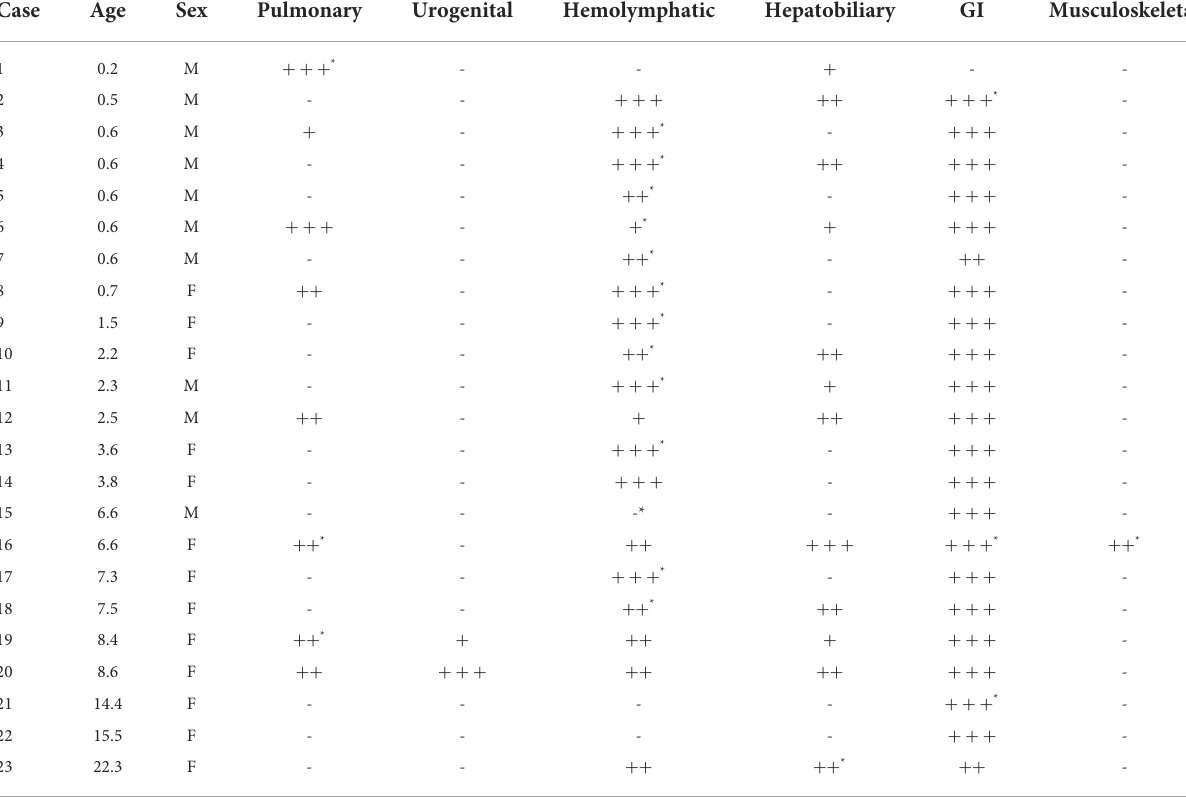
a Casesareorderedbyageinyears.Lesionswerescoredforseverity(-nolesions; + mild; ++ moderate; +++ severe).F,Female;M,Male;GI,Gastrointestinalsystem.*Denotespositive